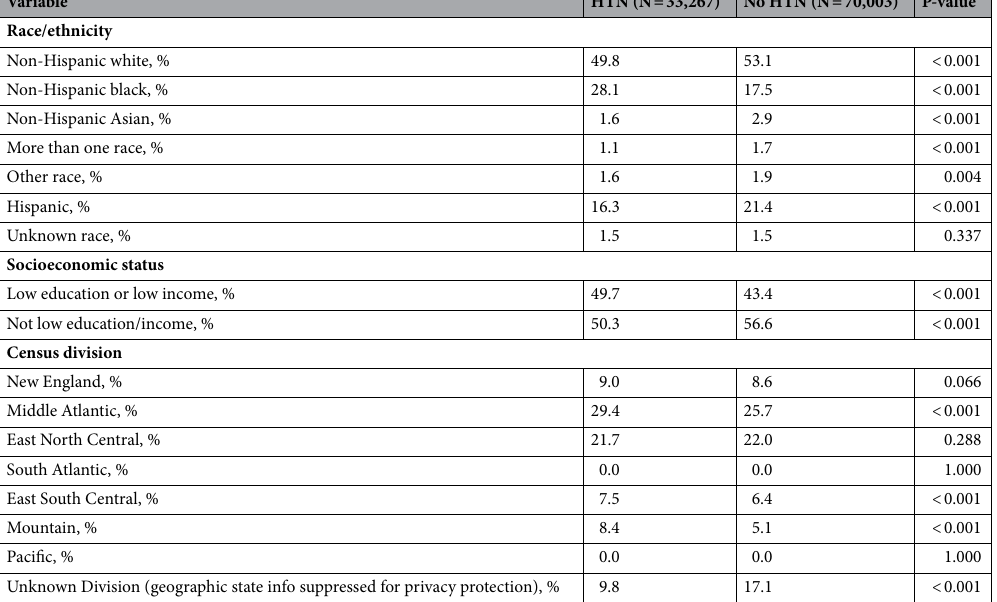
Table 1. Sociodemographic Characteristics of the All of Us Research Program Electronic Health Record Dataset in January 2020 Among Participants with HTN and Without HTN 1 . 1 Numbers represent column percentage.